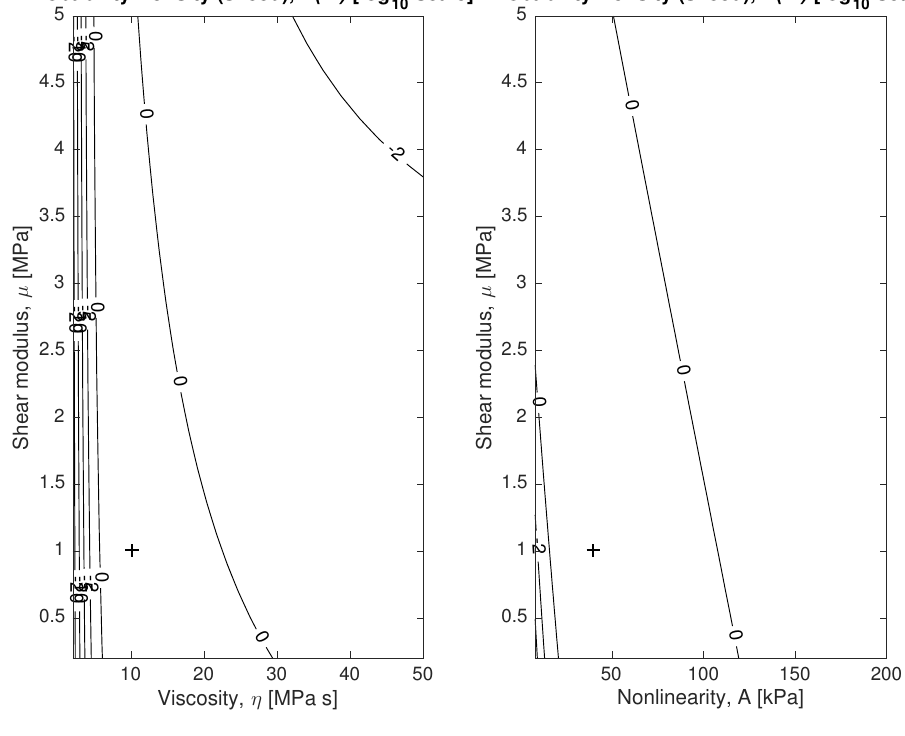
Figure 5. Plausibility maps of model parameters { µ , η } ( left ) and { µ , A} ( right ) given hypothesis H 1 . Plus sign represents optimal shear modulus and viscosity ( left ) and shear modulus and Nonlinear Elastic Constant A ( right